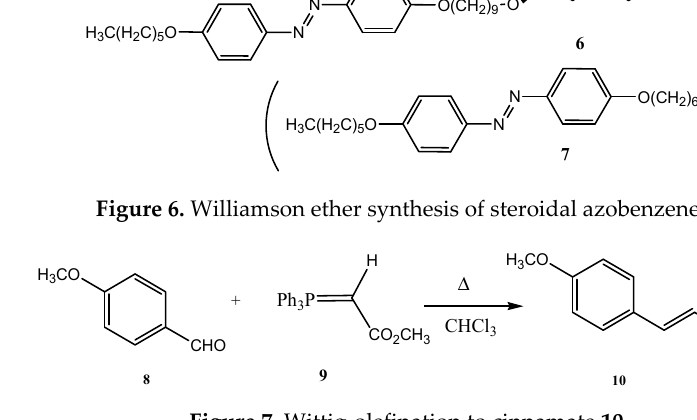
Figure 7. Wittig-olefination to cinnamate 10